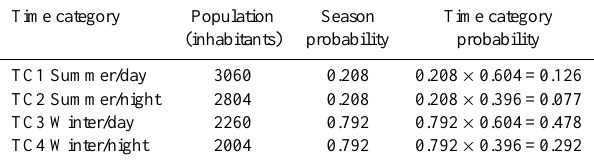
Table 5. Time categories and probabilities.